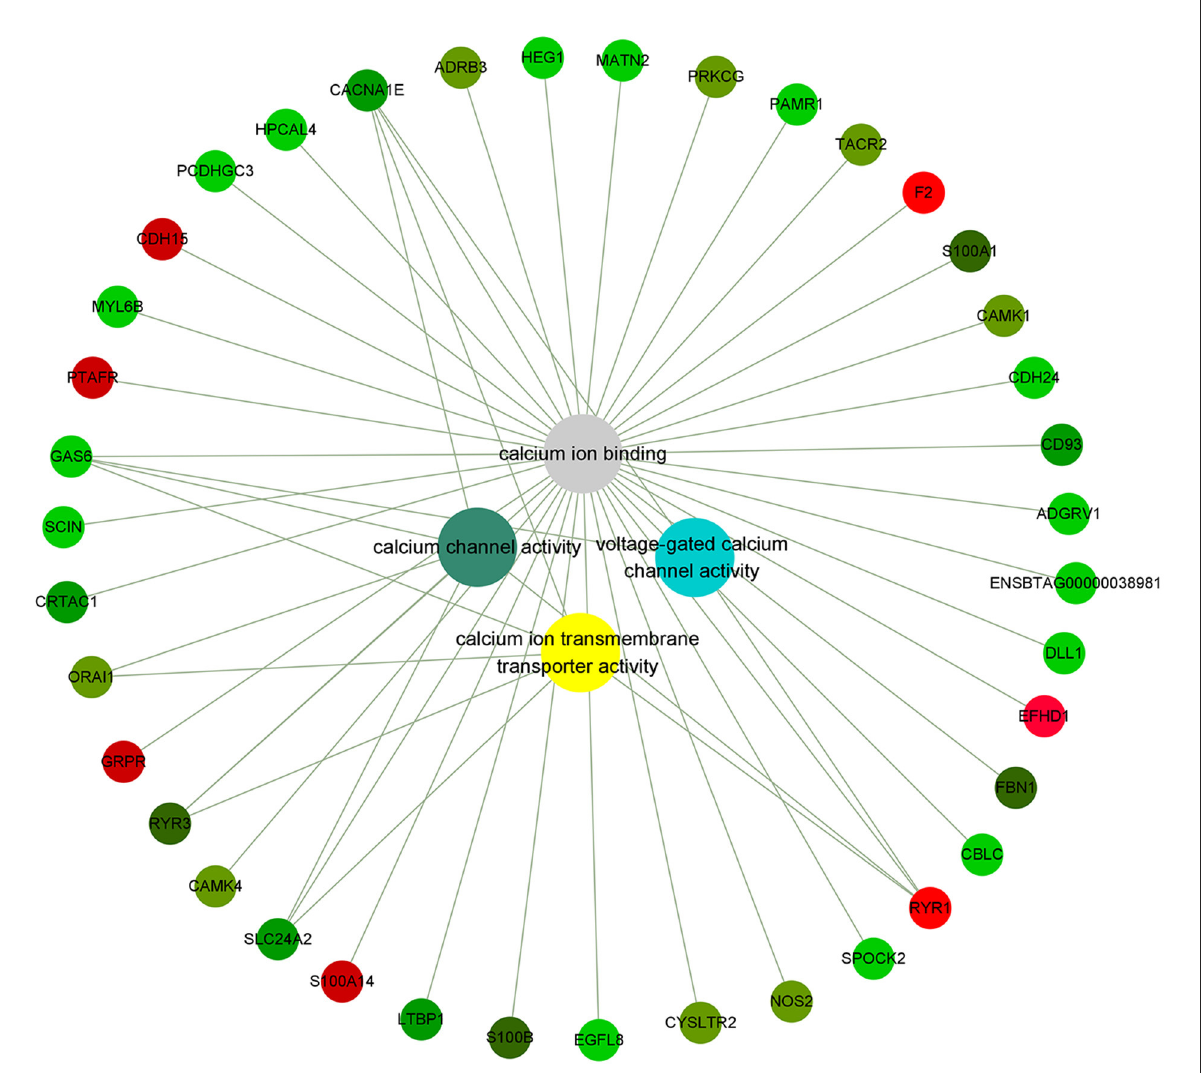
FIGURE3 Genes related to calcium ion binding in PMNL that were differentially expressed in LCAL group. The color intensity indicates the degree to which the relative expression increases (red) or decreases (green) [mean ± SEM ( n = 5)]. This pathway was generated through the use of Cytoscape